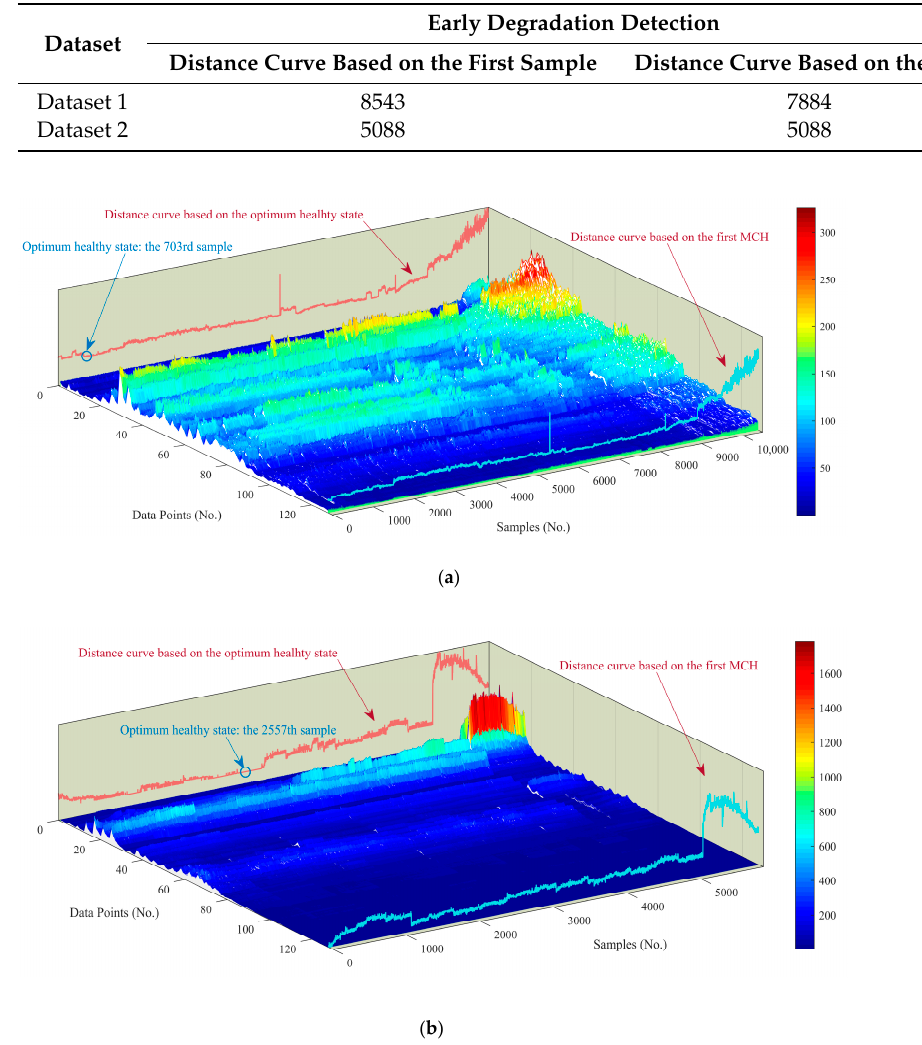
Figure 17. Comparison among feature maps and distance curves based on different baselines: ( a ) Dataset 1, ( b ) Dataset 2. ( a ) Dataset 1, ( b ) Dataset